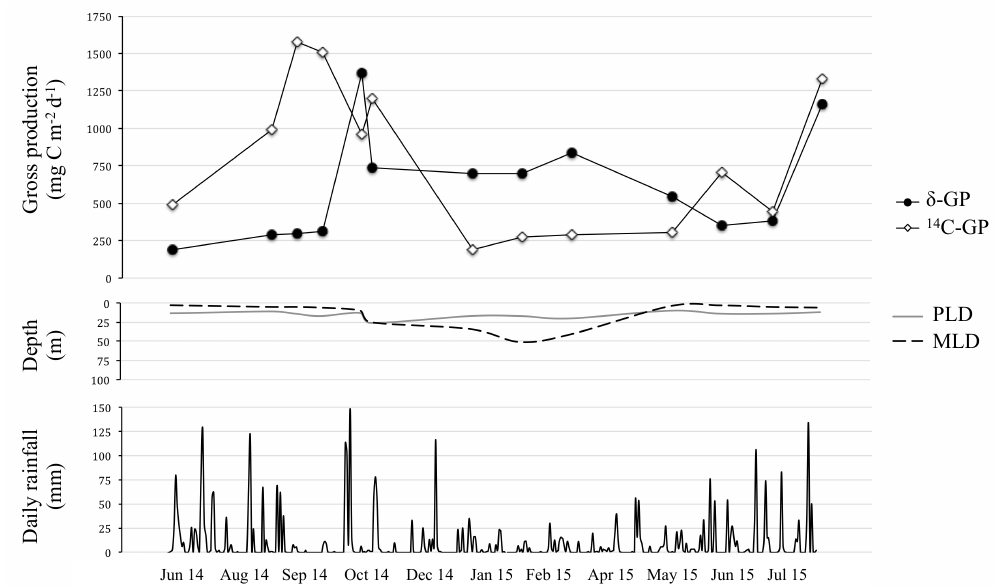
Figure 6. Comparison between dual-delta ( δ -GP) estimates and 14 C–GP rates (mg Cm − 2 d − 1 ). PLD and MLD indicate photic layer depth and mixed-layer depth, respectively, and precipitation shows the total daily rainfall (mm).